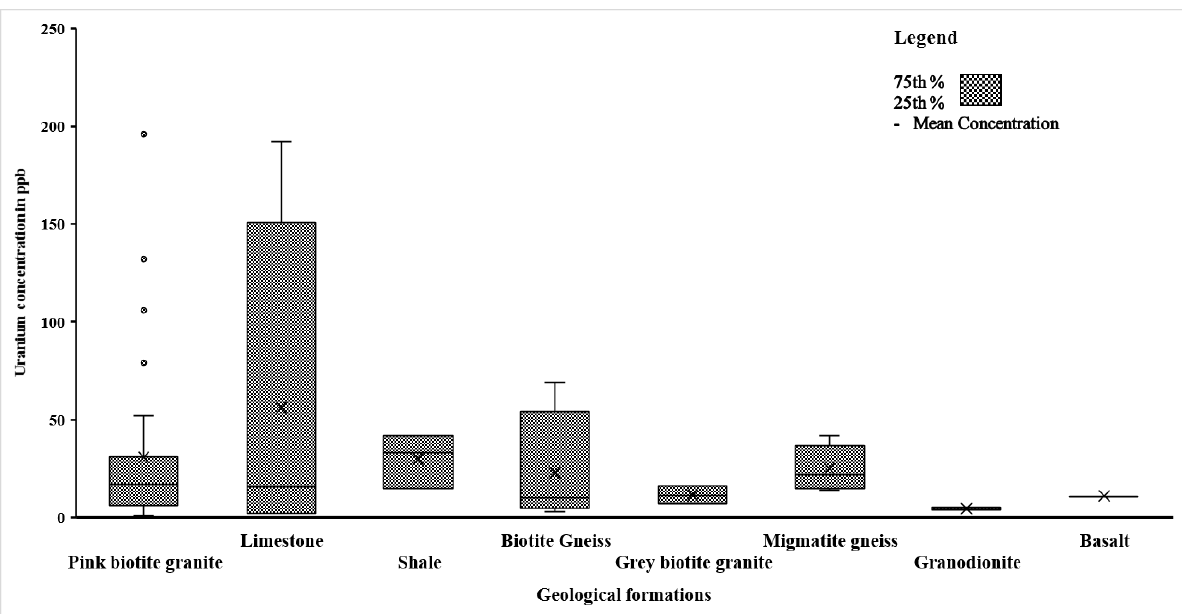
Figure 10. Uranium concentration in groundwater of wells located in different rock types.